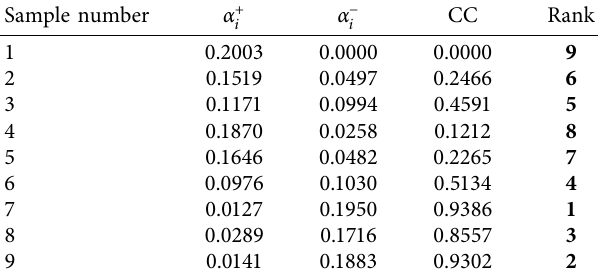
Table 6: Ranking of the